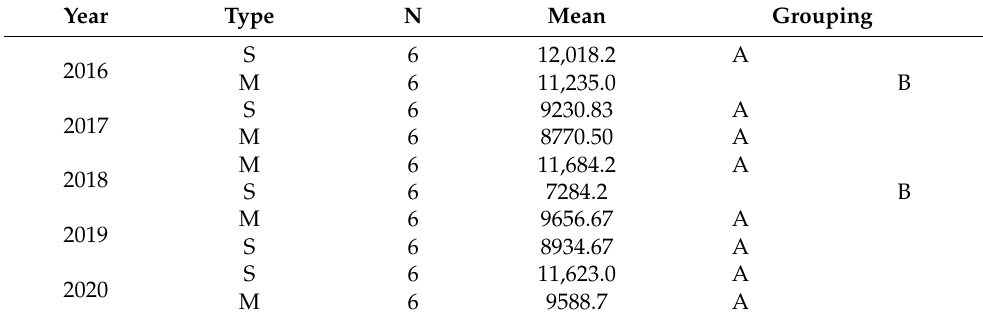
Table 14. Tukey Pairwise